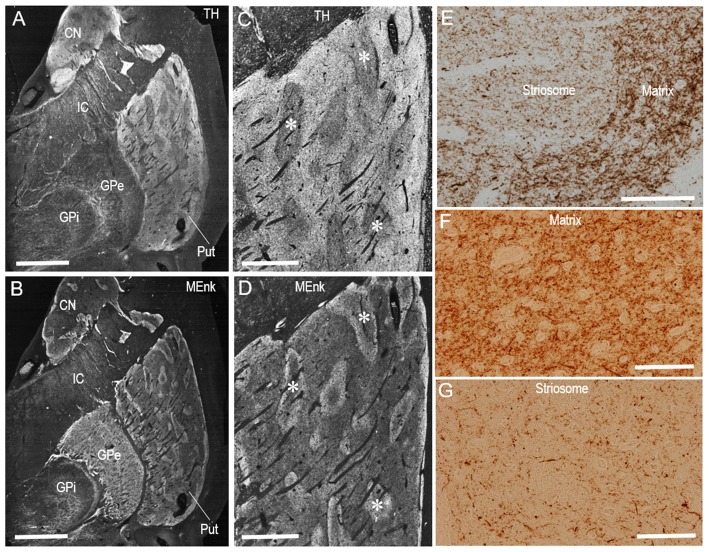
Compartmental distribution of TH immunoreactivity in the caudal putamen of the human brains. (A–D) Serial-section analysis of dark-field images of the lenticular nucleus (A,B) and caudal putamen (C,D) stained with DAB for TH (A,C) and MEnk (B,D). Asterisks indicate examples of corresponding striosomes. (E) Photomicrograph at the border between the striosome and matrix in a putaminal area stained with DAB for TH. (F,G) Photomicrographs of the matrix (F) and striosome (G) in the putamen stained with DAB for TH. Note that the matrix area revealed a greater density of TH-positive fibers and puncta, compared with the striosomal area. Abbreviations: CN, caudate nucleus; Put, putamen; GPe, globus pallidus externa; GPi; globus pallidus interna; IC, internal capsule. Scale bars: (A,B) 5 mm, (C,D) 2 mm, (E) 500 μm, (F,G) 100 μm.